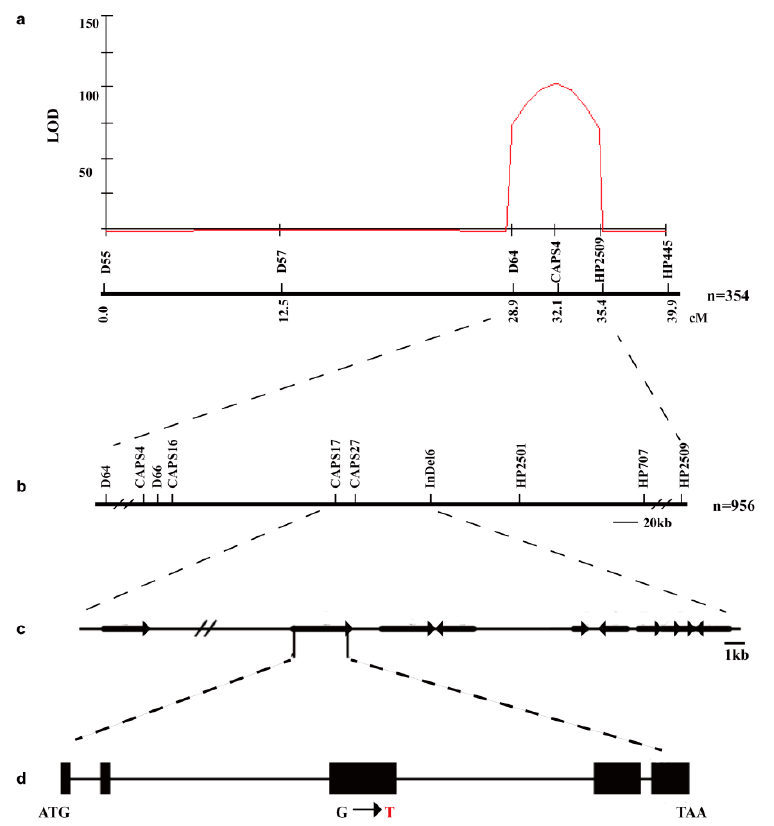
Figure 4. Map-based cloning of ei locus. ( a ) The genetic map of ei on chromosome 2, mapped using 354 F 2 individuals and six polymorphic markers. ( b ) The ei locus was fine-mapped to the interval between markers CAPS17 and InDel6. ( c ) Predicted genes in the region encompassing the ei locus. The arrows indicate the direction of transcription. ( d ) Gene structure and the mutation site. The black rectangles and black line indicate exons and introns, respectively. The red letter represents the mutation base in mutant P502.